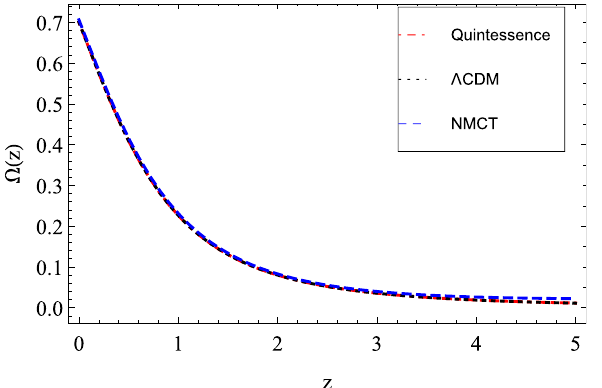
Fig. 2 The energy density versus the redshift for the Λ CDM , quintessence and NMCT models